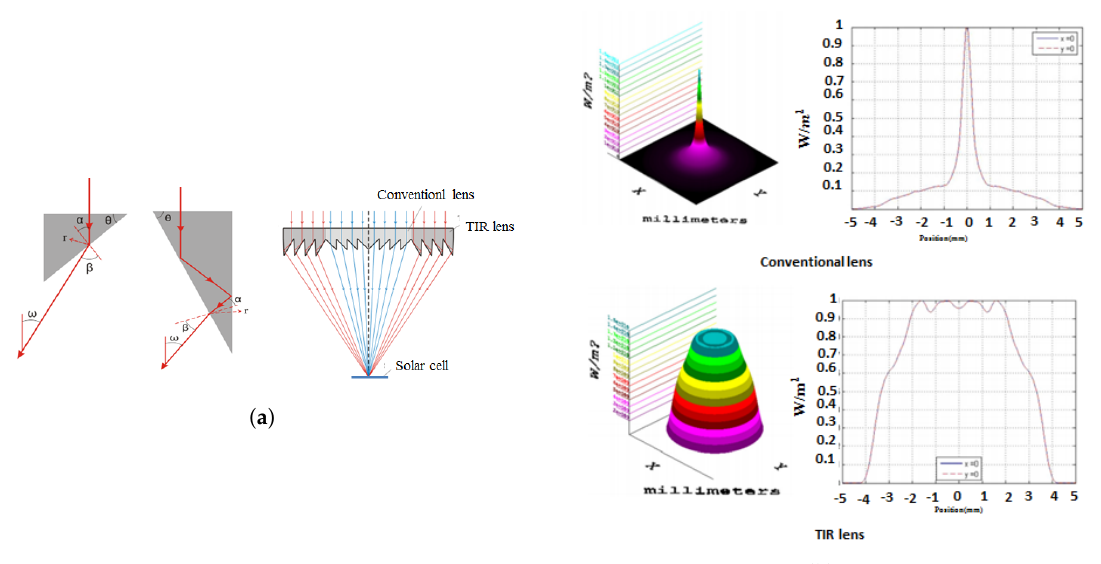
Figure 9. Fresnel lens proposed by Zhuang and Yu. Reprinted from Z. Zhuang et al., Optimization design of hybrid Fresnel-based concentrator for generating uniformity irradiance with the broad solar spectrum. Optics & Laser Technologys 2014, 27, with permission from Elsevier. ( a ) Fresnel lens composed of conventional and TIR prisms proposed by Zhuang and Yu. [17]; ( b ) flux distribution on the solar cell using the Fresnel lens proposed by Zhuang and Yu [17].